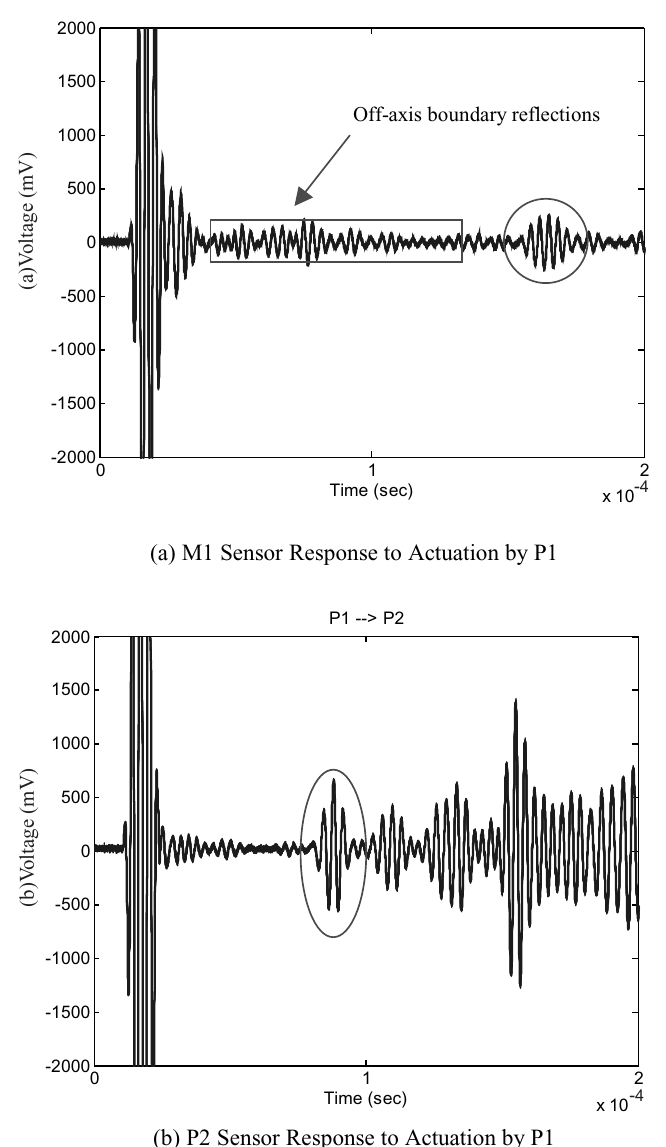
Fig. 10. Baseline Measurements from Different Actuator-Sensor Pairs (red circles indicated first arrival of S 0 mode) (a) M1 Sensor Response to Actuation by P1; (b) P2 Sensor Response to Actuation by P1. The Lamb wave propagations of ten baselines, with P1 as an actuator and M1 as a sensor (which can be considered as co-location), and the actuator-sensor pair of P1 and P2, with the first arrival of the S 0 mode, are shown in Fig. 10. Only one out of five measurements is shown. The group velocity for both S 0 and A 0 is measured to be approximately 5-m/ms, and 3.4-m/ms respectively. These velocities are measured between P1 and P2 and are close to the